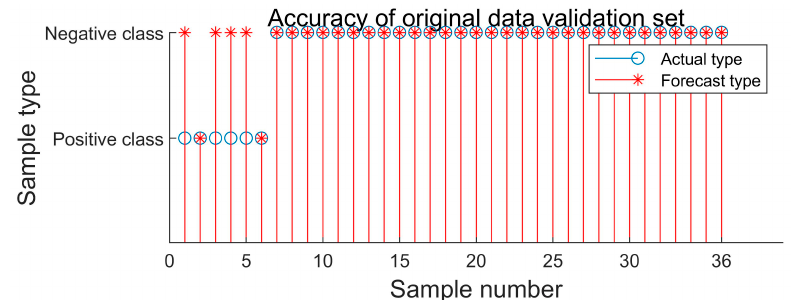
Figure 6. Echocardiogram raw dataset validation accuracy.